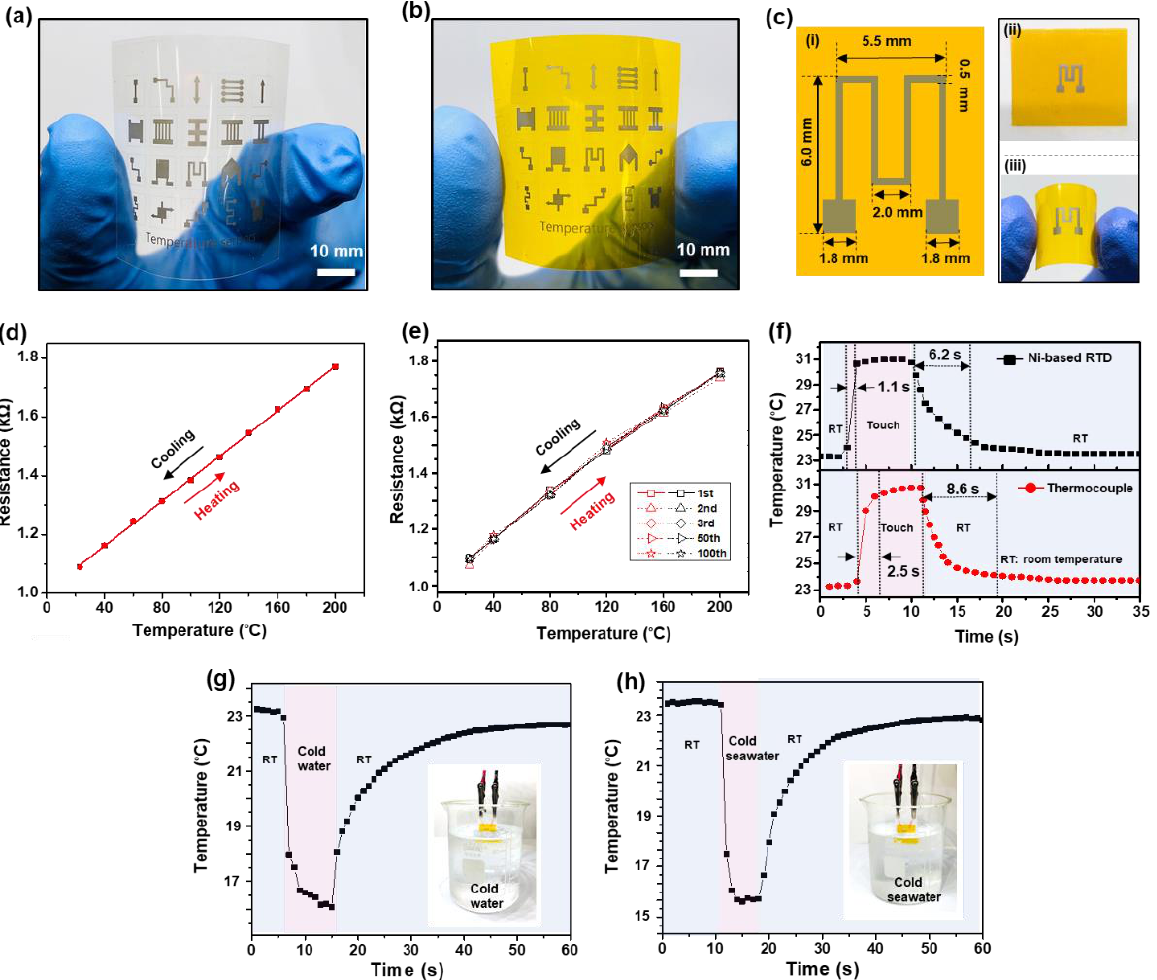
Figure 4. ( a ) Photo image of Ni-based resistance temperature detectors (RTDs) on a polyethylene terephthalate (PET) substrate. ( b ) Photo image of Ni-based RTDs on a polyimide (PI) substrate. ( c ) Schematic drawing of the Ni-based RTD ( i ) and photo images of the real sample ( ii and iii ). ( d ) The resistance variation with temperature showing a linear relationship. ( e ) 100 thermal cyclic tests of the Ni-based RTD. ( f ) Responses of the Ni-based RTD ( top ) and a commercial thermocouple (Type K, EA11A) ( bottom ) to the latex-gloved finger touching test. Responses of the Ni-based RTD to ( g ) tap water and ( h ) seawater. The insets are photo-images of the Ni-based RTD immersing in the water and seawater, respectively.